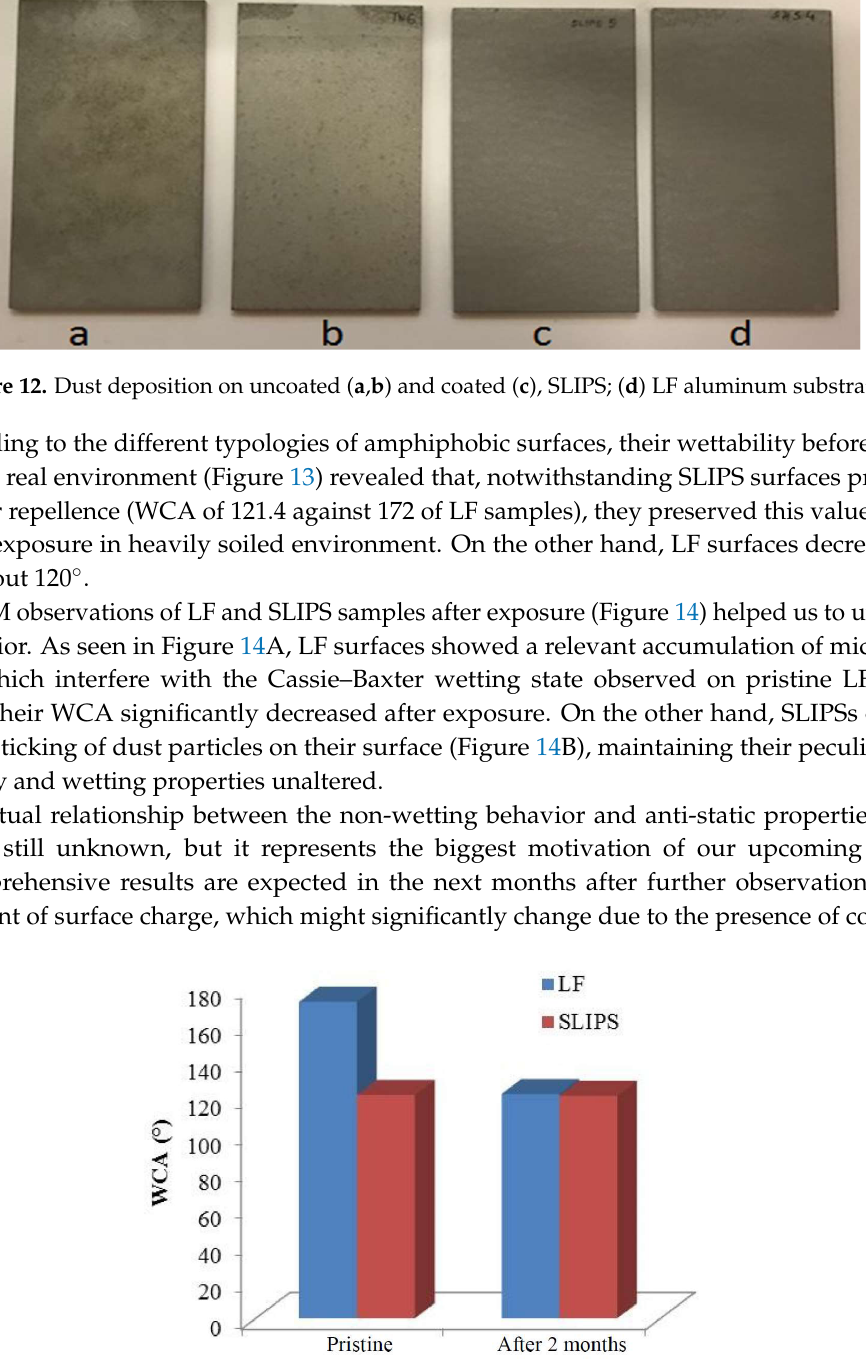
Figure 13. Water contact angle (WCA) of the coated aluminum samples before (in blue) and after 2 months (in red) of exposure in Karachi, Pakistan .